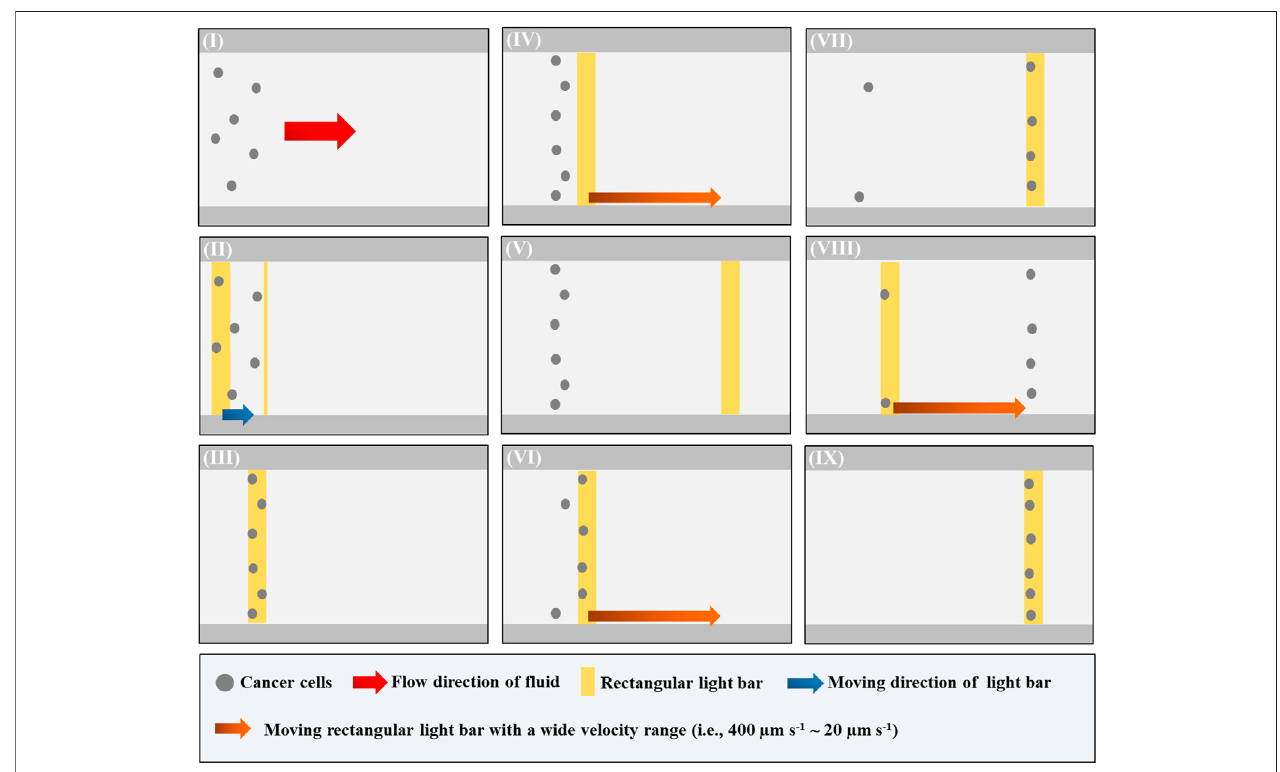
FIGURE 2 | Schematic presentation of the operating procedures for the evaluation of “ maximum velocity ” of the dynamic light image that can manipulate cells (or ODEP manipulation velocity): (I) a cell suspension sample was loaded and then transported to the upstream area of the ODEP-based cell manipulation zone via fl uid control,(II – III)thecellstestedweremovedtothestartlineofODEP-basedcellmanipulationzoneusingamovingrectangularlightbar,(IV – V)amovingrectangularlightbar withahighmovingvelocity(e.g.,400 μ m s − 1 )was fi rstusedtomanipulatethecells.Ifnocellwaseffectivelymanipulated,themovingvelocityofthelightbarusedfor the next round of screening was progressively reduced (set decrement: 20 μ m s − 1 ), (VI – VII) once a cell was able to be manipulated by the moving light image with a particular moving velocity. This velocity was regarded as the “ maximum velocity ” of the dynamic light image that can manipulate cells (i.e., ODEP manipulation velocity), and (VIII – IX) the “ screening process ” [i.e., (IV – VII)] was continuously performed at a set velocity decrement of 20 μ m s − 1 until all the tested cells were effectively manipulated (a video clip is provided as a Supplementary Material